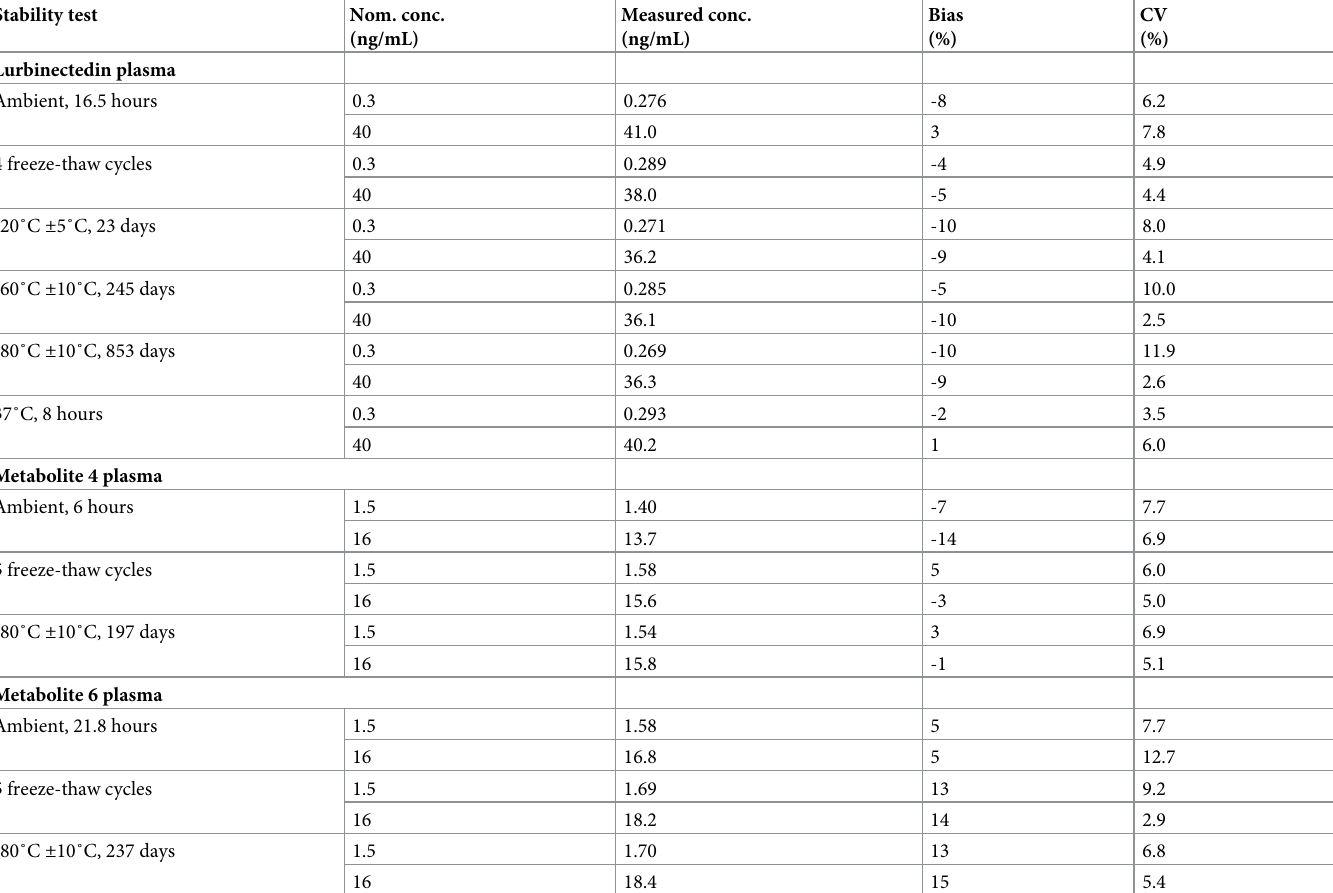
Table 3. Stability of lurbinectedin and its metabolites M4 and M6 in human K 3 -EDTA plasma under different test conditions. Stability